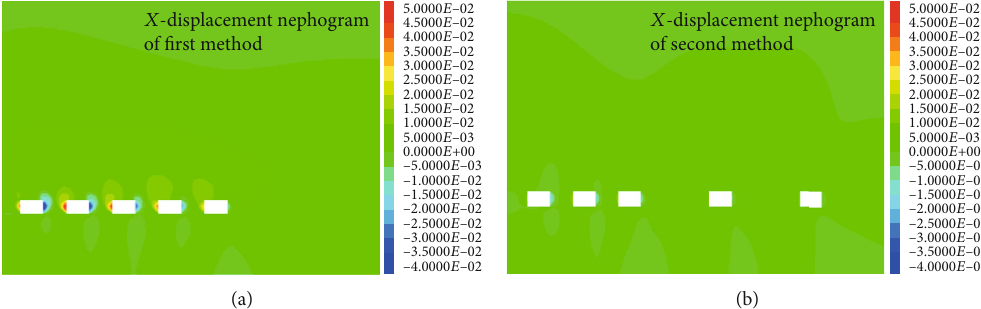
Figure 8: X -displacement nephogram of the fi fth borehole. (a) Displacement nephogram of the fi rst method. (b) Displacement nephogram of the second method.